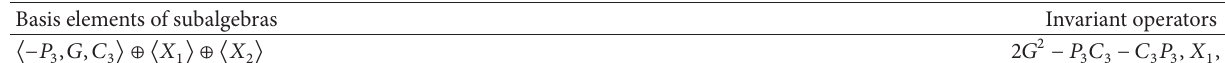
Table 7: Invariant operators of subalgebra of the type 𝐴 3,8 ⊕ 𝐴 1 ⊕ 𝐴 1 . Basis elements of subalgebras Invariant